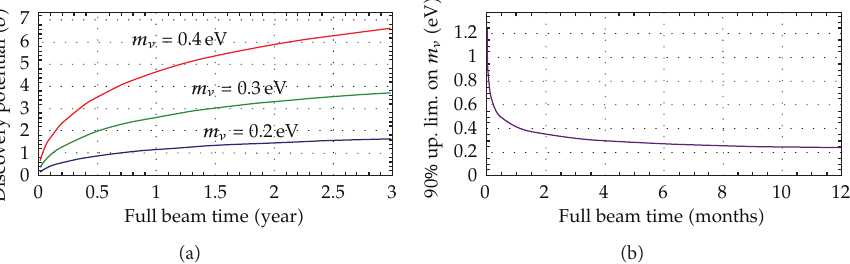
Figure 26: (a) Discovery potential of KATRIN as function of time for different neutrino masses. (b) Upper limit on neutrino mass at 90% C.L. as a function of